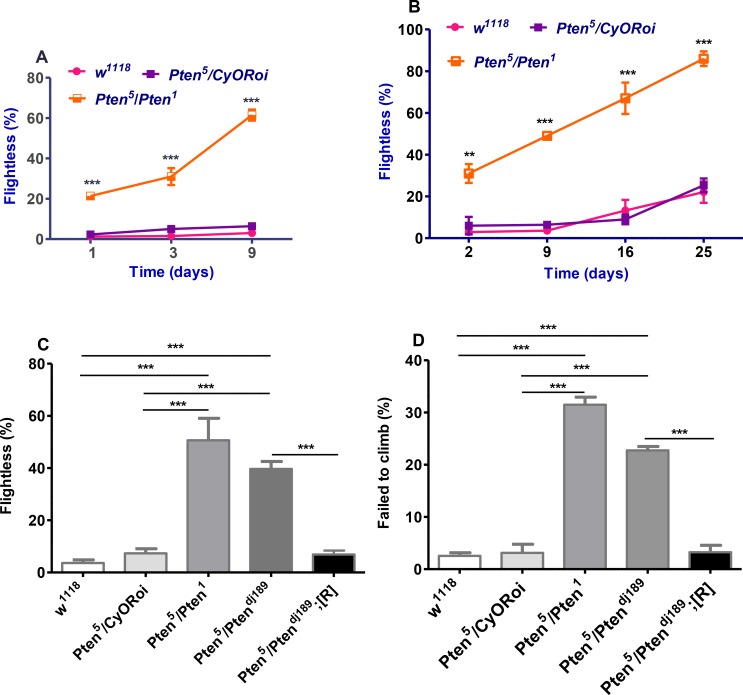

Pten
5 transheterozygous mutants exhibit Pten-associated locomotive phenotypes.
(A,B) Flight tests of adult females of different genotypes over a 9 day (A) and 25 day (B) period. (A)
Pten
5 transheterozygous mutant female flightlessness rises between 3 and 9 days (***P<0.001) and is significantly higher than w
1118 and heterozygous Pten
5
/CyORoi controls over a 9 day period; ***P < 0.001 relative to both controls. There was no statistically significant difference between wild type w
1118 and heterozygous control Pten
5
/CyORoi at any time point; graphs represent pooled data from six experiments, n ≥ 120. (B) Frequency of flightless phenotype for Pten
5 transheterozygous mutant female flies continues to increase (P < 0.001 from days 2–9, 9–16 and 16–25 days) and be significantly greater than control w
1118 and Pten
5
/CyORoi females over a 25 day period. Data from at least six independent experiments. **P < 0.01, ***P < 0.001, n ≥ 100, determined by two-way ANOVA with Bonferroni post-hoc correction for A and B. (C) Flightless phenotype in 9-day-old Pten
5 transheterozygous female flies is strongly rescued by a Pten genomic construct; pooled data from six experiments; *** P < 0.001, n ≥ 100. (D) 9-day-old Pten
5 transheterozygous mutant males display a defective geotaxic phenotype compared to w
1118 controls, Pten
5
/CyORoi heterozygotes or genomic rescue flies, assessed by scoring flies that failed to climb 6 cm in 30 sec; n ≥ 50, *** P < 0.001. Significance determined by one-way ANOVA with Bonferroni post-hoc correction for C and D. Graphs present as mean ± SEM.